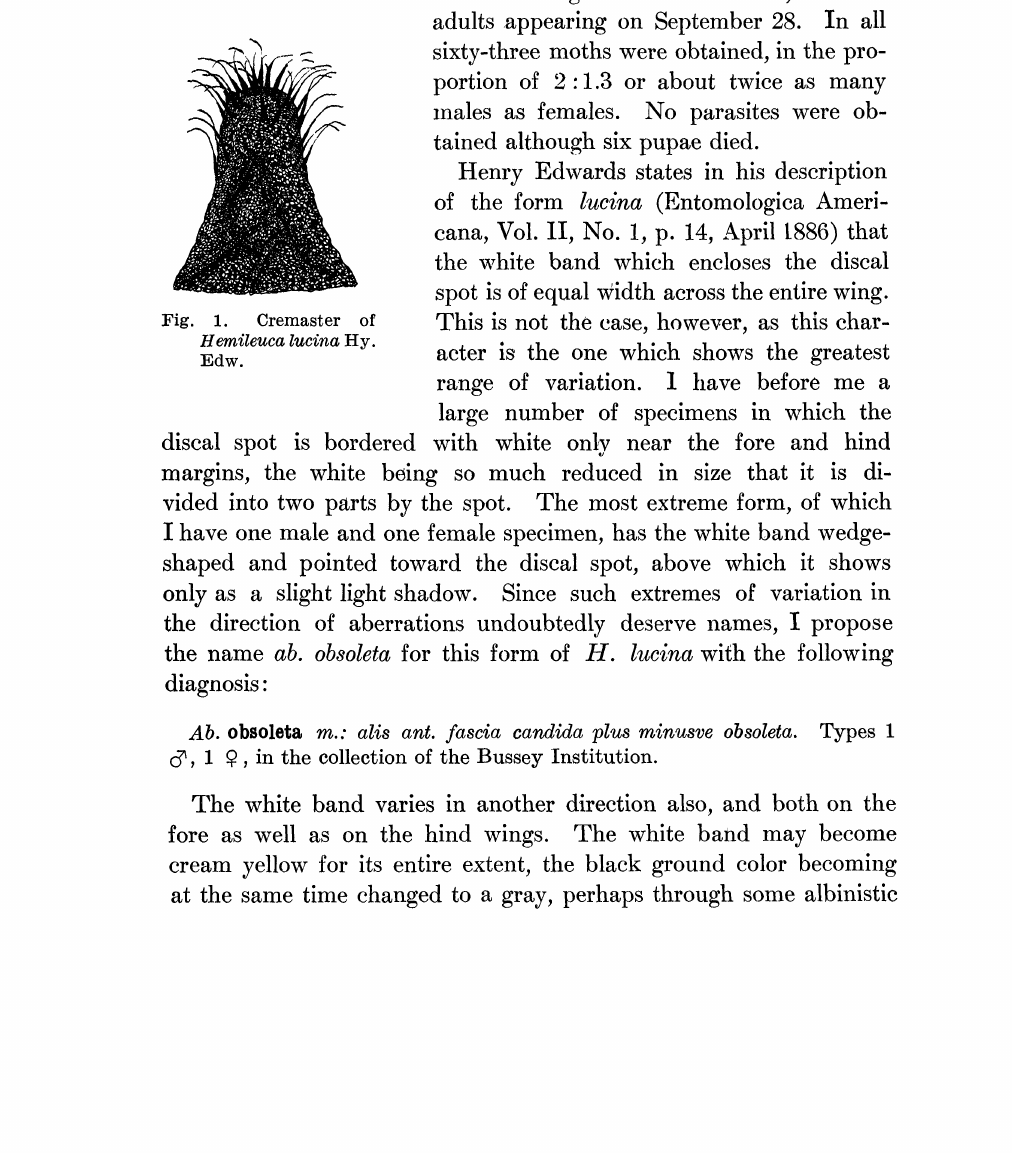
:Fig. 1. Cremaster of This is not the case, however, as this char- H emileuca lucina Hy. Edw. range of